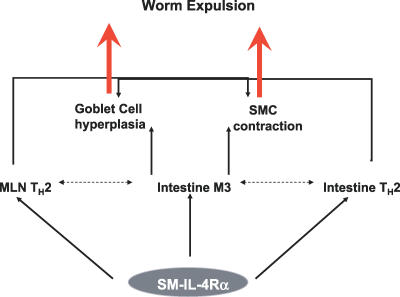
Role of Smooth Muscle IL-4Rα in N. brasiliensis InfectionSolid arrows represent demonstrated effects of smooth muscle IL-4Rα on the host response to N. brasiliensis infection. Dotted arrows indicate other potential and/or likely interactions.